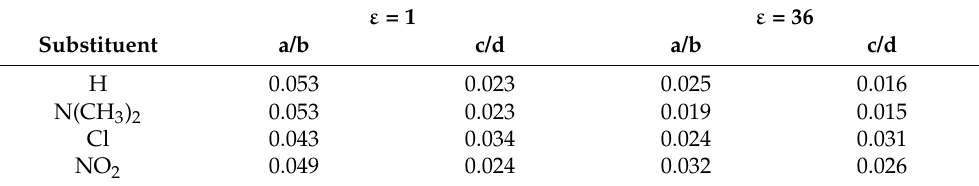
Table 5. RMS deviation of the partial charges between isomers a and b (columns a/b) and between isomers c and d (columns c/d) for DFT calculation in gas phase ( ε = 1) and acetonitrile ( ε = 36) for different substituents. ε = 1 ε = 36 Substituent a/b c/d a/b